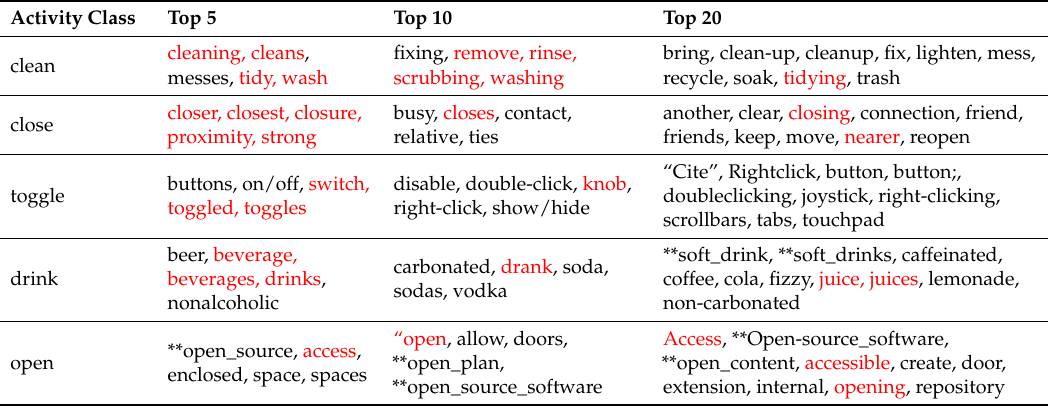
Table A5. Top 20 most similar words for each activity class in the OPP dataset. The symbol ** indicates that “DBPEDIA_ID/” has been omitted. The color of red represent synonyms and blue for antonyms. Activity Class Top 5 Top